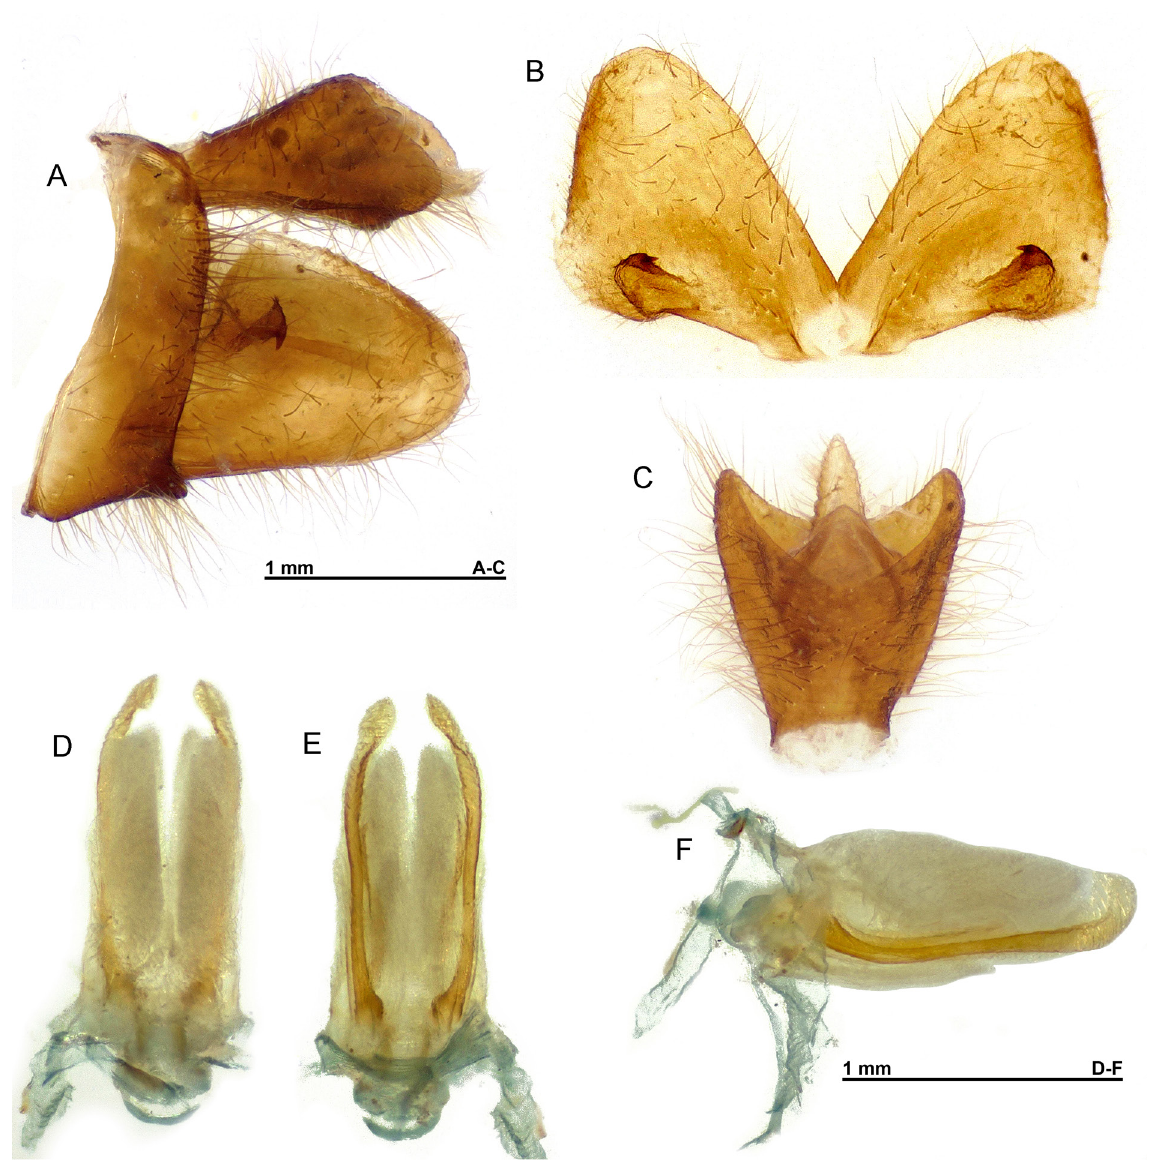
Fig. 10. Limois westwoodii (Hope, 1843), Myanmar, Nat Ma Taung, RBINS, male genitalia. A . Left lateral view (except phallic complex). B . Gonostylus, ventral view. C . Anal tube, dorsal view. D – F . Aedeagus. D . Dorsal view. E . Ventral view. F . Left lateral view. Photographs by J.